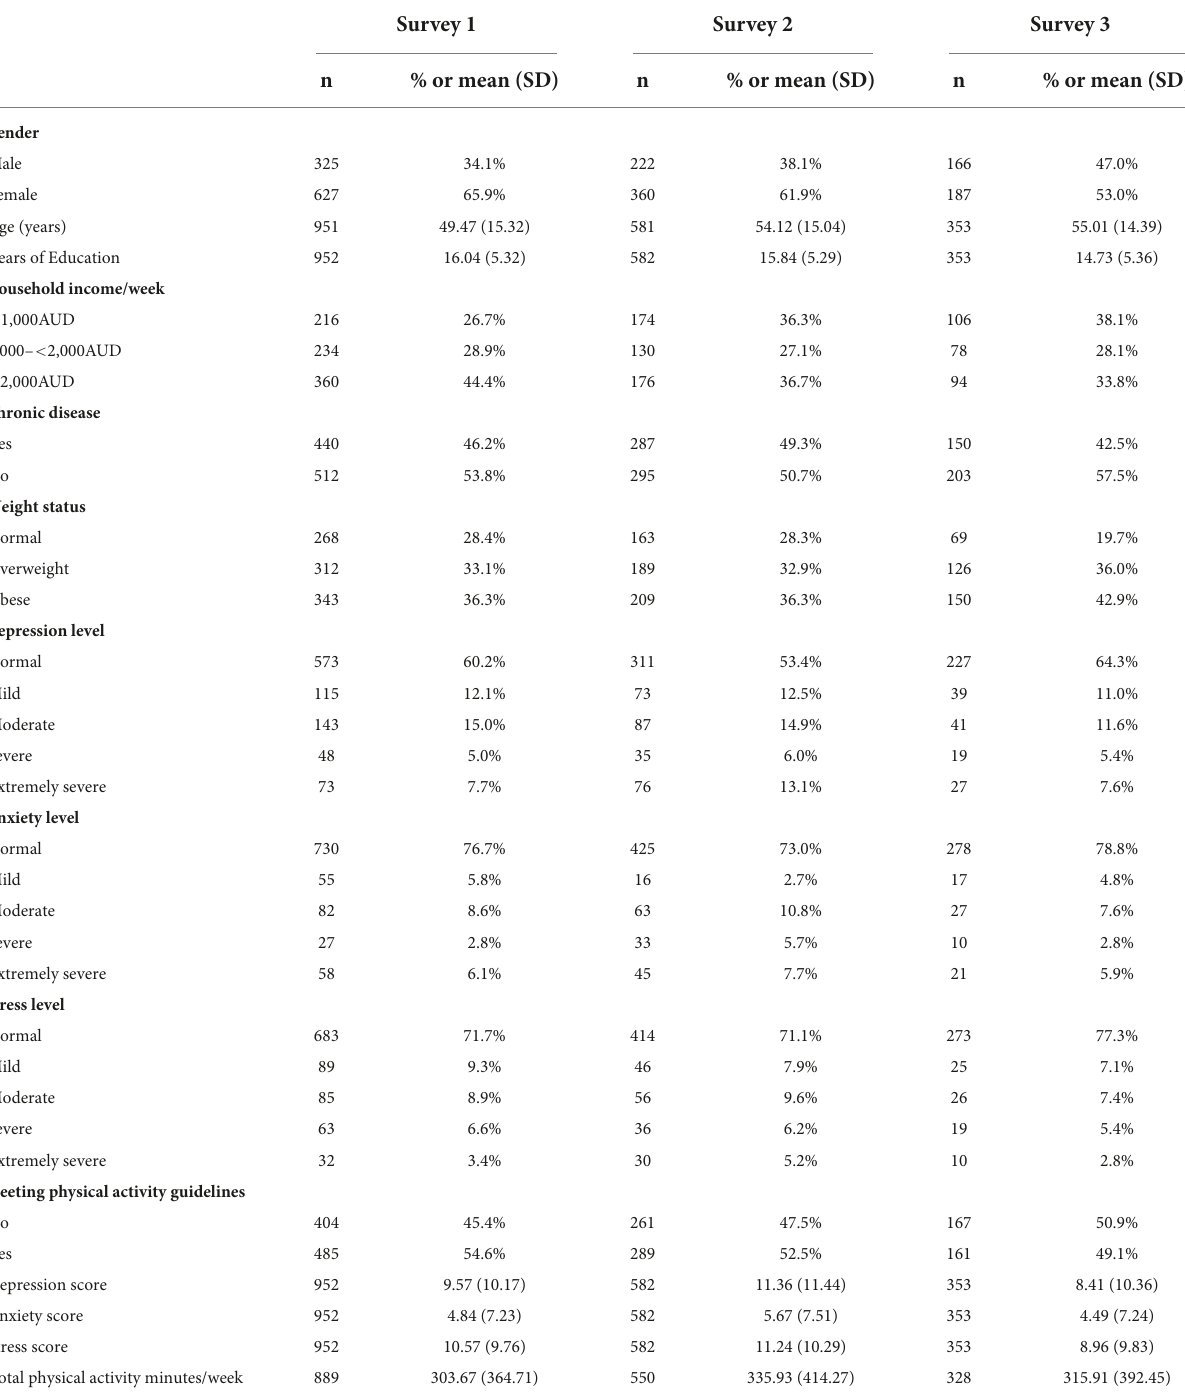
TABLE 2 Sociodemographic characteristics of the cross-sectional